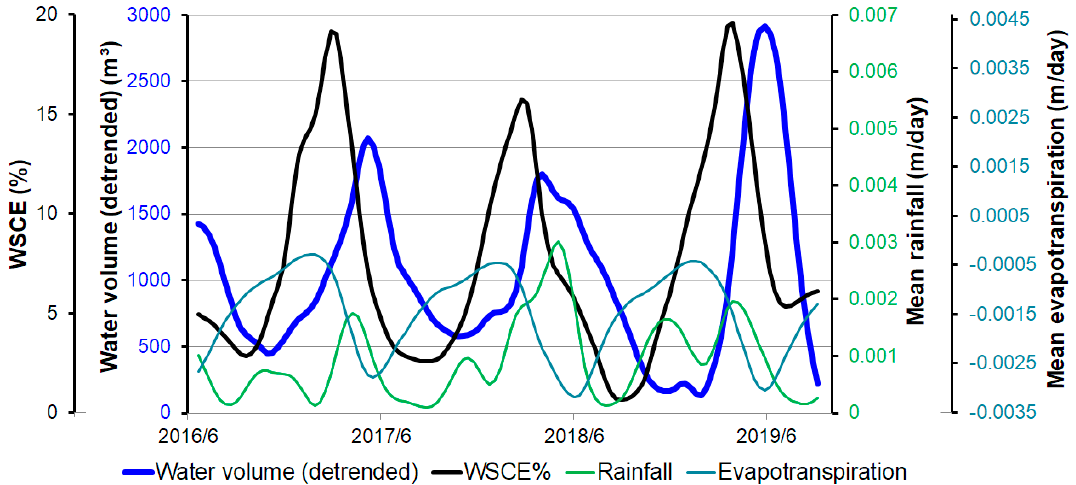
Figure 9. The time series detrended water volume of Lake Urmia and the WSCE%, as well as hydrological factors, including liquid rainfall and evapotranspiration.